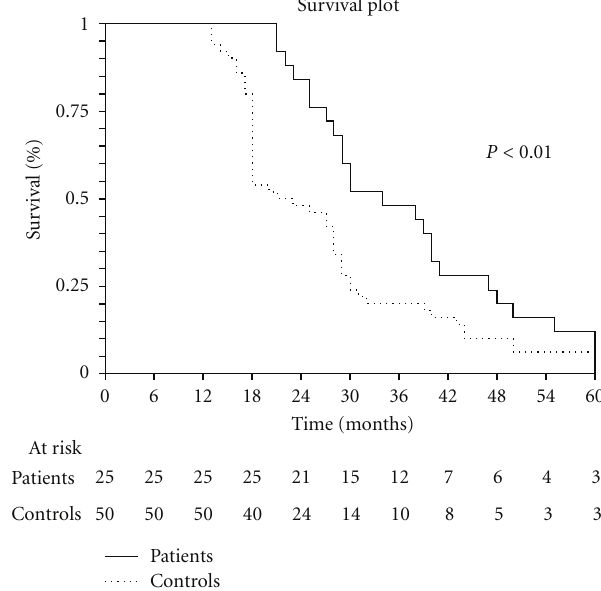
1 underwent a wedge resection for a single hepatic metastasis (alive disease-free at 31 months) and 2 cytoreduction and HIPEC for peritoneal metastases (alive with disease at 26 and 24 months). Four patients are currently alive with disease and 9 died from progression at a mean of 15.6 months.